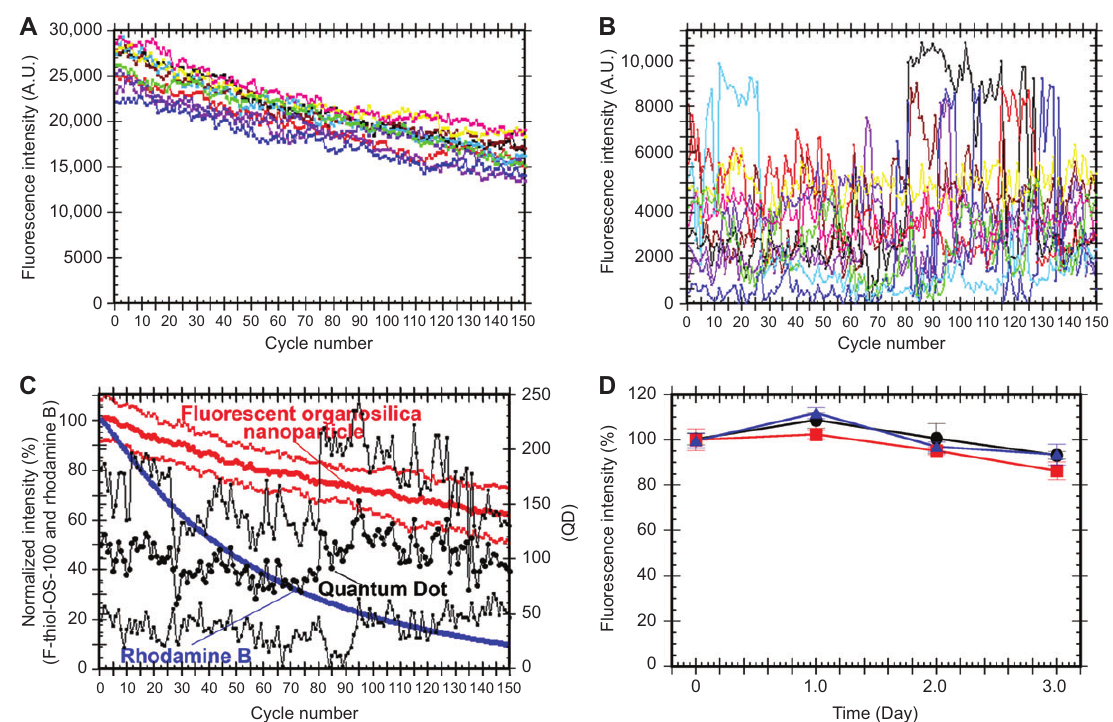
Figure 4 Comparison of photophysical properties of fl uorescent organosilica nanoparticles, quantum dots, and rhodamine B molecules. Fluorescence microscopic evaluation of the fl uorescent intensities of 10 single fl uorescent organosilica nanoparticles (A) and 10 single quan- tum dots (B) over 150 cycles (1 cycle = 100 ms). (C) Fluorescence microscopic evaluation of the quantitative ability of fl uorescent organosilica nanoparticles (red circles and red solid line), quantum dots (black circles and black solid line), and rhodamine B (blue solid line). The mean (large circle) and standard deviation (SD; small circle) of fl uorescent intensity of 10 particles and the concentration of fl uorescent intensity of rhodamine B were calculated. Fluorescent intensities were normalized with regard to fl uorescent intensities at cycle 0 for fl uorescent organo- silica nanoparticles and rhodamine B, and with a mean intensity for quantum dots. Normalized values and SDs of fl uorescent organosilica nanoparticles and rhodamine B appear on the left y -axis, whereas those of quantum dots appear on the right y -axis. (D) Restoration of fl uo- rescent intensity of fl uorescent organosilica nanoparticles. Fluorescent organosilica nanoparticles were incubated in water (black), phosphate buffered saline pH 7.4 (red), or phthalate solution pH 4 (blue). Fluorescent intensities were normalized to those on day 0. Data are presented as mean values and SDs for three experiments. From Ref. [147] ; reproduced with kind permission from